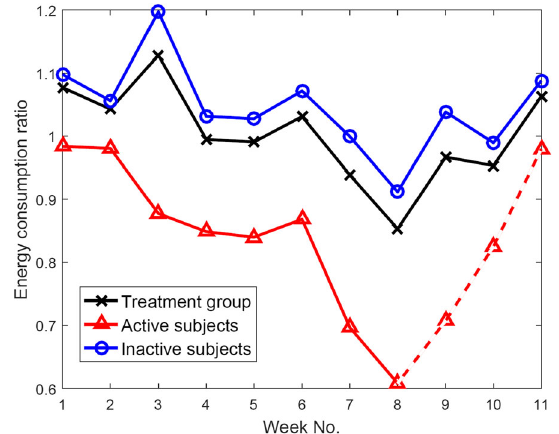
Fig. 7 Energy consumption ratio at 1 – 7 pm for active/ inactive subjects by week, based on their baseline